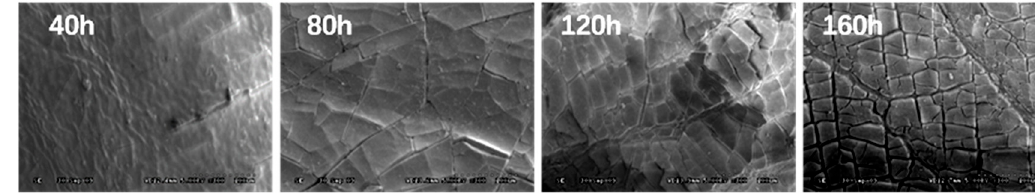
Figure 10. SEM scanning of SBS-modified asphalt binders under different UV radiation times.